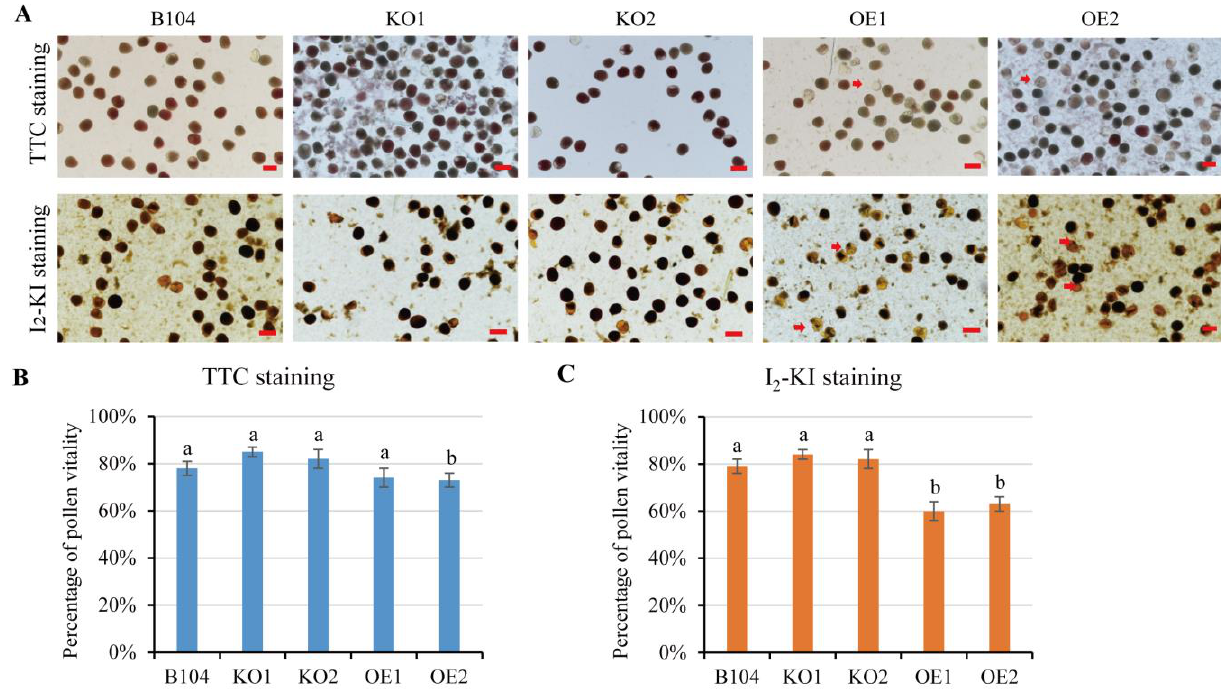
Figure 5. Evaluation of pollen vitality in vitro via TTC or I 2 - KI staining. ( A ) Microscopic observation of pollen via TTC or I 2 - KI staining. ( B ) Percentage of pollen vitality via TTC staining. ( C ) Percentage of pollen vitality by I 2 - KI staining. Scale bar: 100 μm. Data represent means ± SD of three biological replicates. Significant differences are indicated with different letters ( p < 0.05, one-way ANOVA).